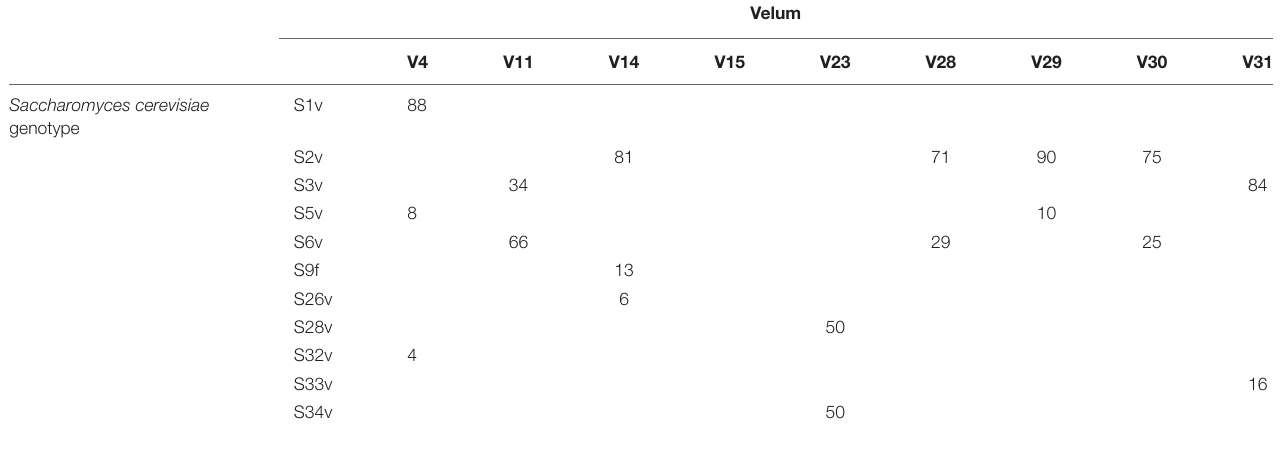
TABLE 3 | Example of the distribution (%) of different Saccharomyces cerevisiae genotypes present in velum (V) showing that several different Saccharomyces cerevisiae strains could be present in a same